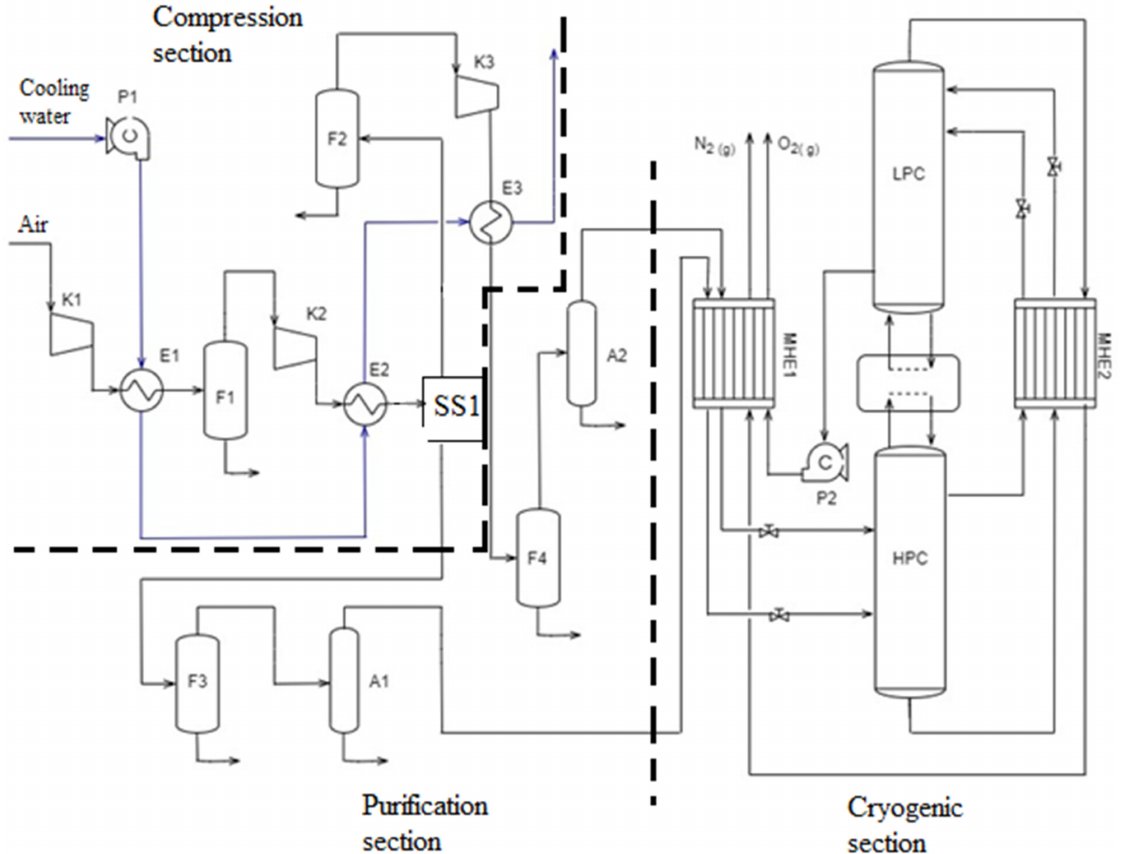
Figure 1. Simple flow diagram of two-column cryogenic air separation model design C1, adapted from [36]. A1,2: adsorbers; E1-3: heat exchangers; F1-4: phase separators; HPC: high-pressure column; K1-3: compressors; LPC: low-pressure column; MHE1,2: multi-stream heat exchangers; P1,2: pumps; SS1: stream splitter. Dashed lines = borders of unit ´ s